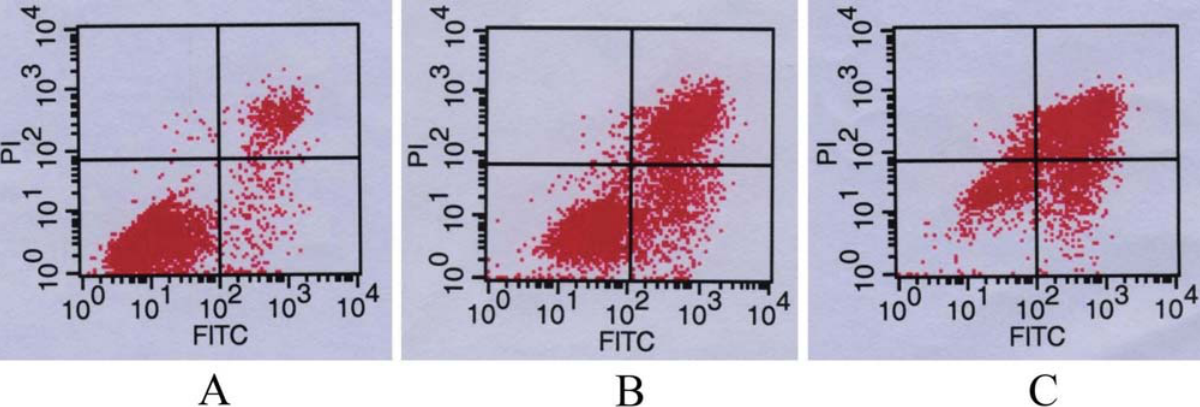
Figure 3- Effect of LM1 and LM2 on apoptosis of CAL-27 cells. A: blank control group; B: CAL-27 cells were treated with LM1 for 10 h; C: CAL-27 cells were treated with LM2 for 12 h. After staining with annexin V and PI, the cells were subjected (cid:14)(cid:22)(cid:4)(cid:26)(cid:22)(cid:12)(cid:4)(cid:9)(cid:20)(cid:14)(cid:22)(cid:27)(cid:8)(cid:14)(cid:13)(cid:20)(cid:4)(cid:15)(cid:17)(cid:15)(cid:10)(cid:20)(cid:11)(cid:16)(cid:11)